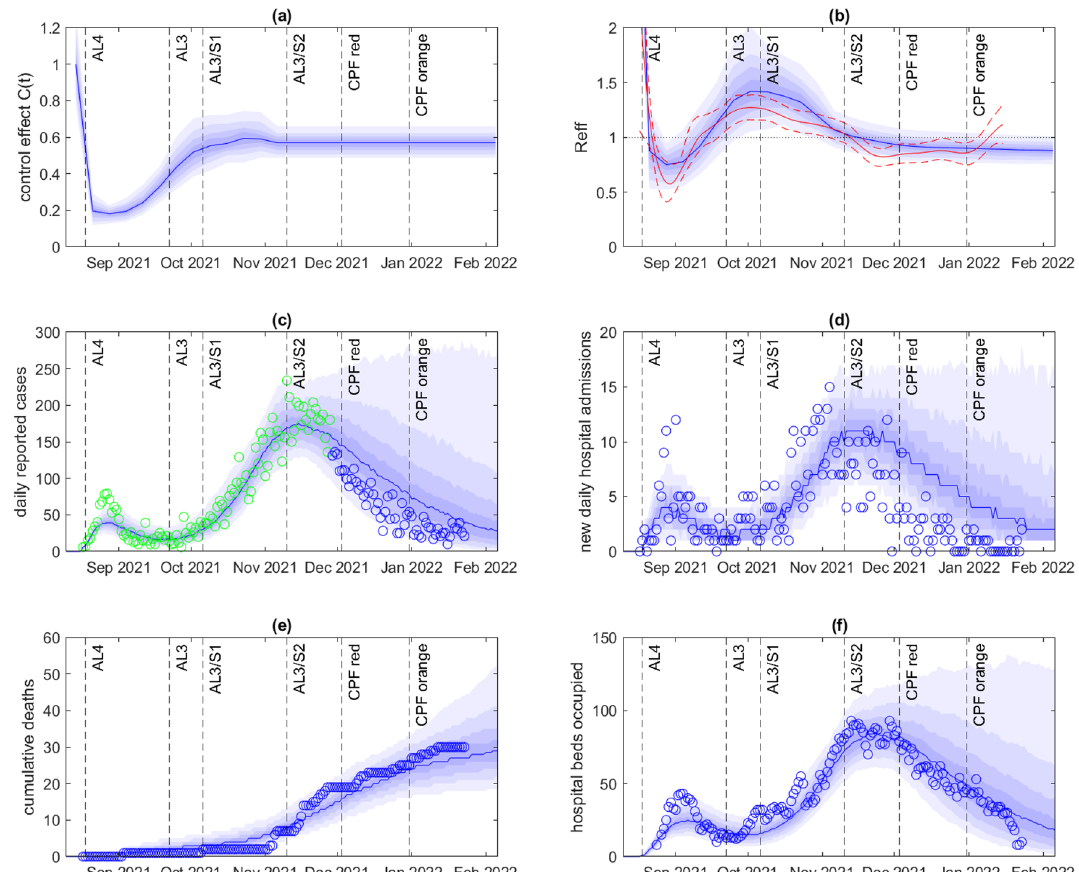
Figure 4. Model results fitted to data up to 28 November 2021. ( a ) Inferred control function C ( t ) ; ( b ) Effective reproduction number R eff ( t ) calculated in the model (blue) based on time-varying control function C ( t ) , and vaccine-derived and infection-derived immunity, and independently estimated using the EpiNow2 package 23,45 (median estimate red solid, 90% credible band red dashed); ( c ) Daily reported cases; ( d ) New daily hospital admission; ( e ) Cumulative deaths; ( f ) Hospital beds occupied. In ( c ), green points show data that was used to fit the control function shown in ( a ). In ( a , b ), the blue curve shows the median and the shaded blue bands show the 10th, 20th, 30th, 40th, 60th, 70th, 80th, and 90th percentiles of the estimated posterior distribution for C ( t ) . In ( c – f ), the blue curve shows the median and the shaded blue bands show the 10th, 20th, 30th, 40th, 60th, 70th, 80th, and 90th percentiles of the specified model output across the best-fitting n = 500 out of 2500 model simulations, each with C ( t ) sampled independently from the estimated posterior. Dashed vertical lines show the times of key changes to public health restrictions for the Auckland region (see Table